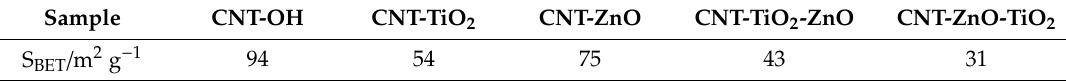
Table 4. The measurements of the specific surface areas of the samples.